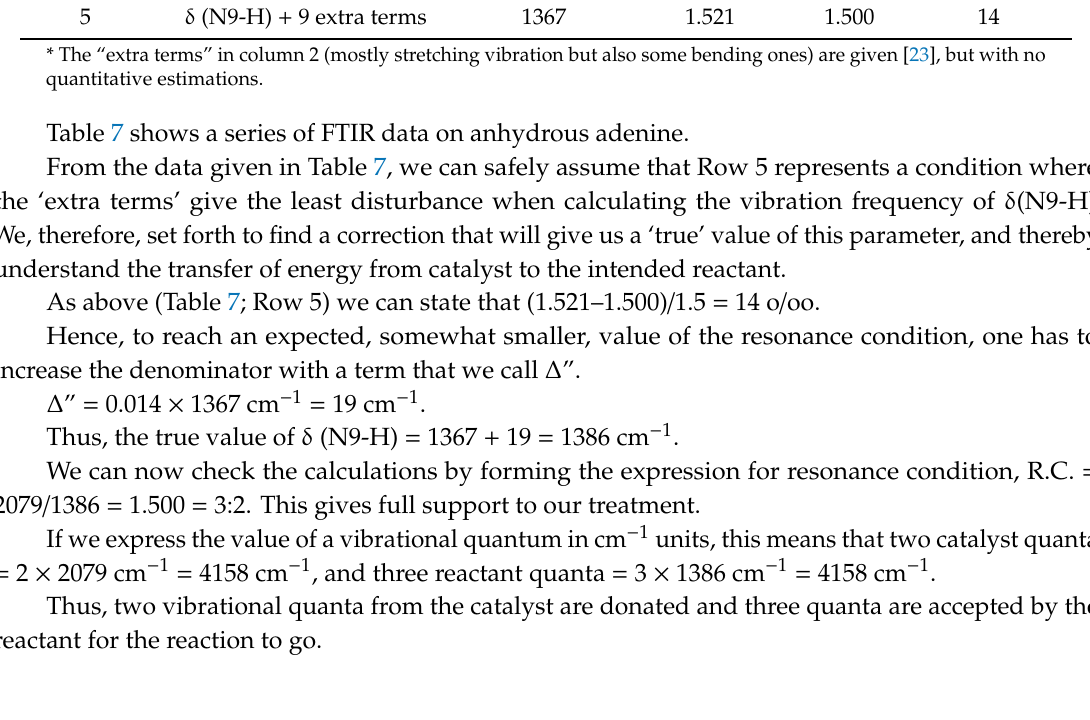
Table 7. Series of FTIR data on anhydrous adenine, numbers 1–5, from an investigation with detailed analysis of the spectral assignments. The “resonance condition” is calculated as was done in Table 1.